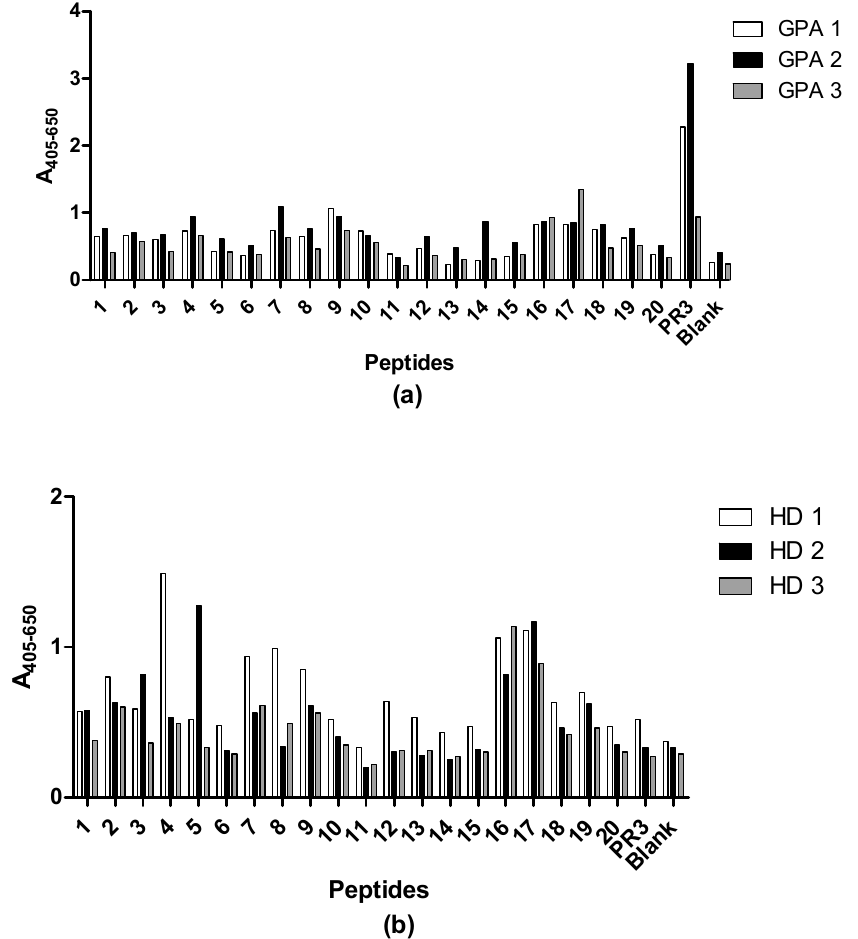
Figure 15. Epitope mapping of PR3 (SSI) using sera from GPA patients and HD and peptide CovaLink-NH ELISA. 20-mer peptides with a 10 amino acid overlap covering the complete proteinase 3 peptide were screened for antibody reactivity. Purified PR3 was used as positive control. ( a ) Reactivity of three GPA patient sera. ( b ) Reactivity of three healthy donor sera.